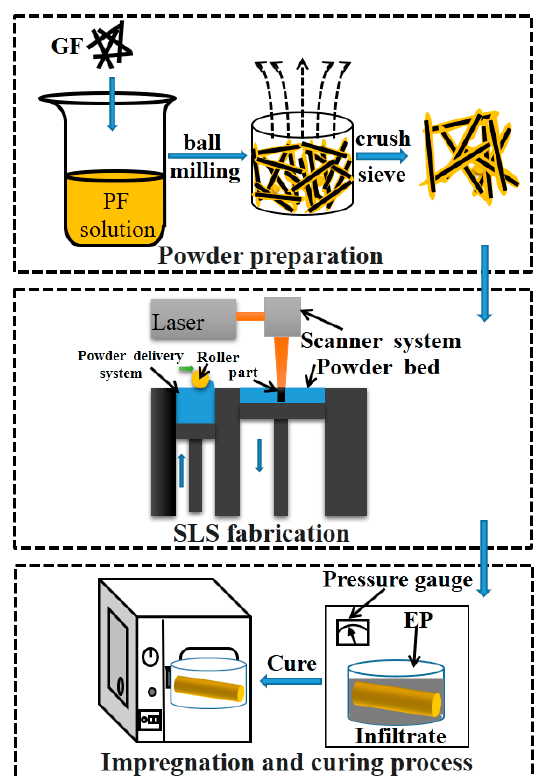
Figure 1. Procedures for the fabrication of the glass fiber (GF)/ phenol formaldehyde resin (PF)/epoxy resin (EP) three-phase composite resin (EP) three-phase composite components.